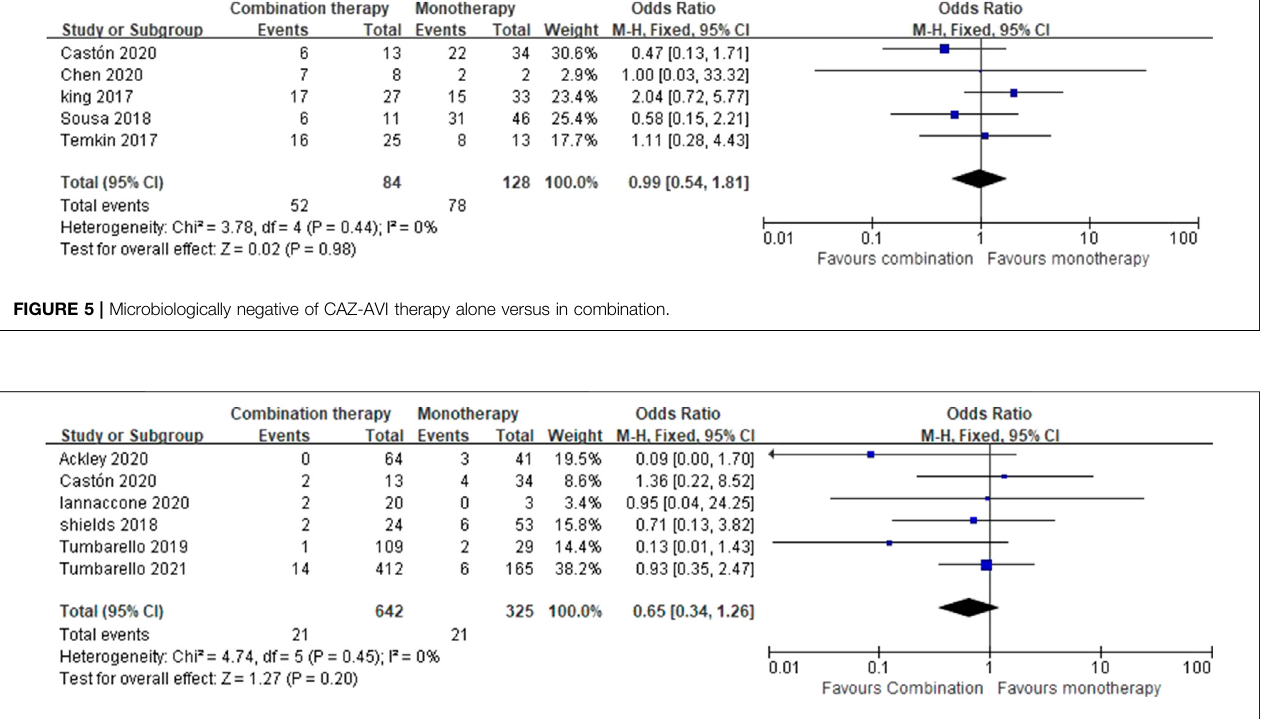
FIGURE 6 | Posttreatment resistance of CAZ-AVI therapy alone versus in combination.